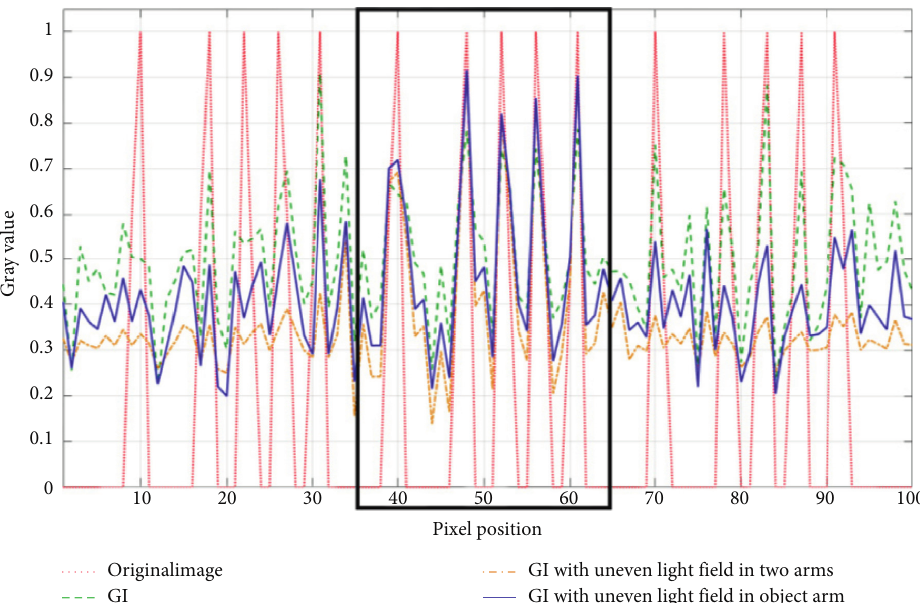
Figure 6: Comparison of the simulation results of Figure 5. Gray values of a target region for Figures. 5(a), 5(c), 5(e), and 5(f) as a function of pixel position, the dashed line indicates the gray value distribution of the imaging target. Inside the black wireframe is the ROI.